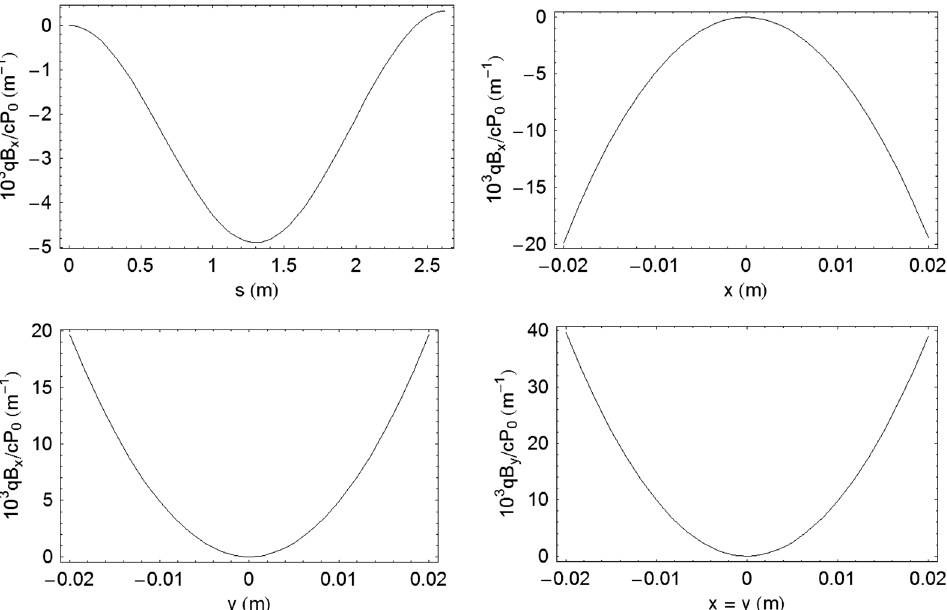
as a function of s for x ρ . Bottom left: B ρ . as a function of y for x ¼ 0 , s ¼ π 12 12 x